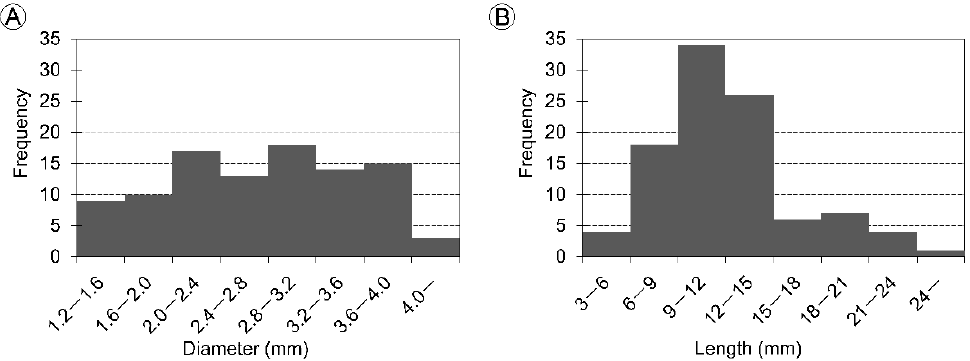
Figure 2. Histograms of the diameter and length of the stalactite minerals (number of samples: 100). ( A ): diameter; ( B ): length.